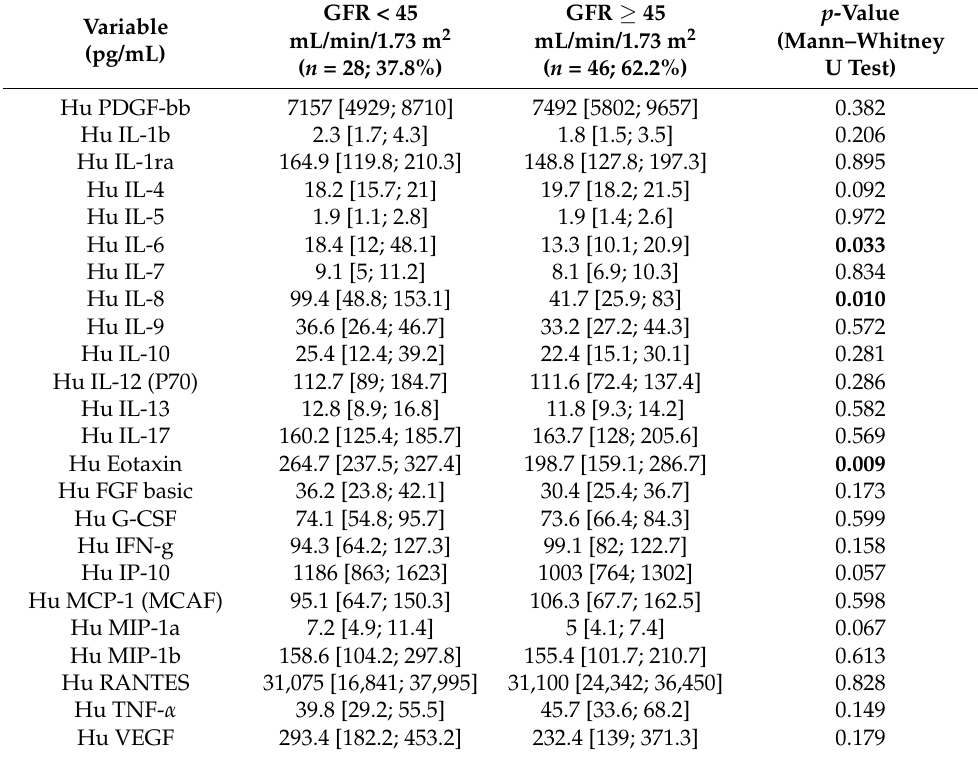
Table 1. Cytokine extended panel and GFR.